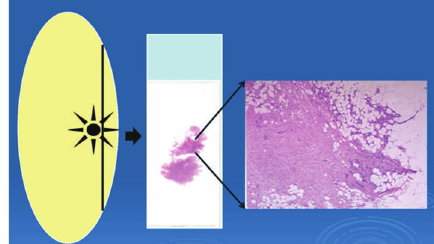
Figure 9: Method of obtaining a (pathologic) shave margin from a specimen. A thin piece is taken from the surface of a specimen and either frozen or processed for microscopy. The slide and microscopy show tumor present in the tissue. This would be considered a “positive” margin.